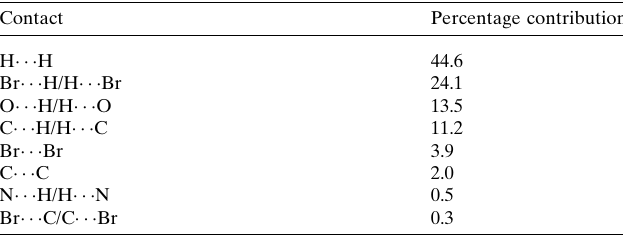
Table 3 Percentage contributions of interatomic contacts to the Hirshfeld surface for the title